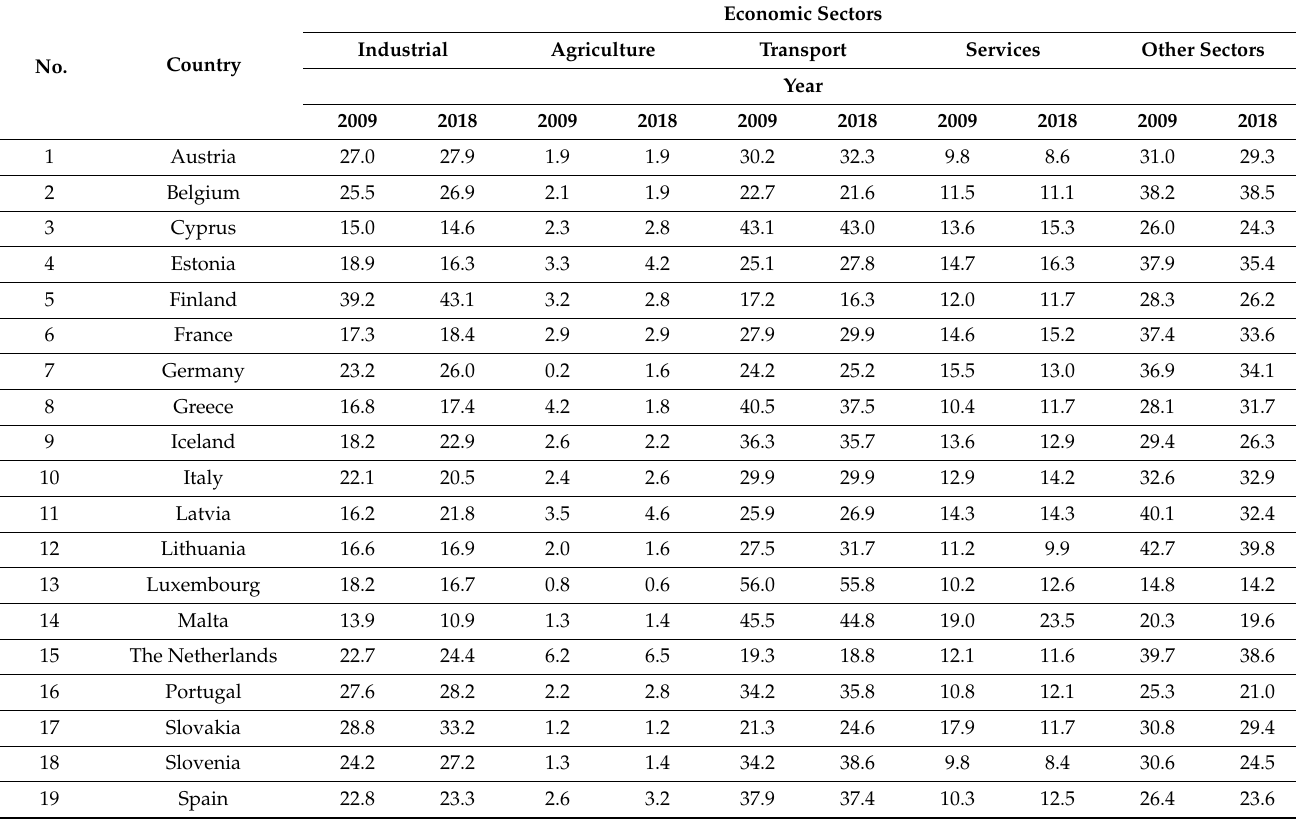
Table 2. Sectoral energy development in various European countries over the 2009–2018 period, energy consumption as a percentage of the total energy consumption (source: